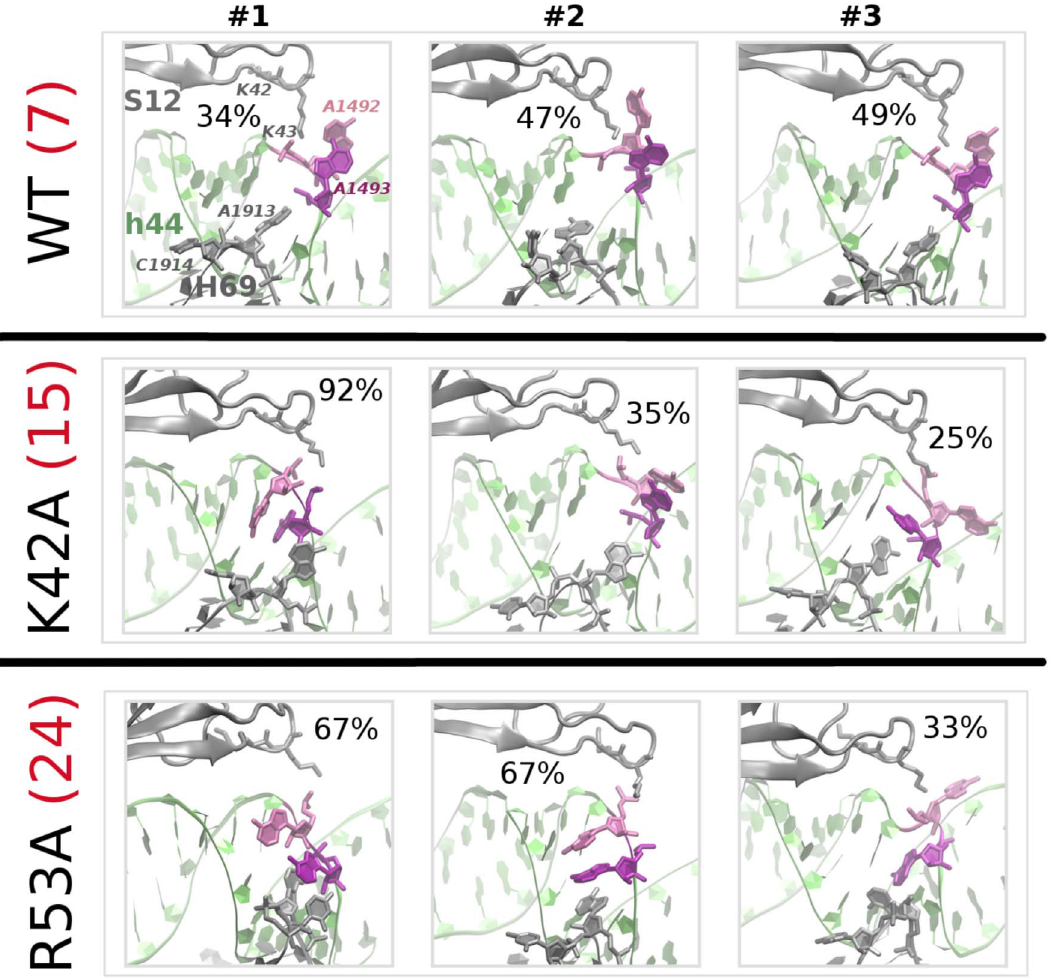
Figure 2. MD conformations of A1492 and A1493 in the uncomplexed A-site. Representatives of final clusters (with occupancies in %) are shown for each simulation run ( # 1, # 2 and # 3), in the variants without paromomycin. The h44 helix is shown in green, S12 (above h44) and H69 (below) are grey, A1492 is pink, and A1493 is purple. K42, K43 (S12), A1492 and A1493 (h44), and A1913 and C1914 (H69) are rendered as sticks (hydrogens are not shown). The number of computed structural clusters across all frames (aggregated over all three trajectories of each simulation variant) is shown in red, after the variant label.